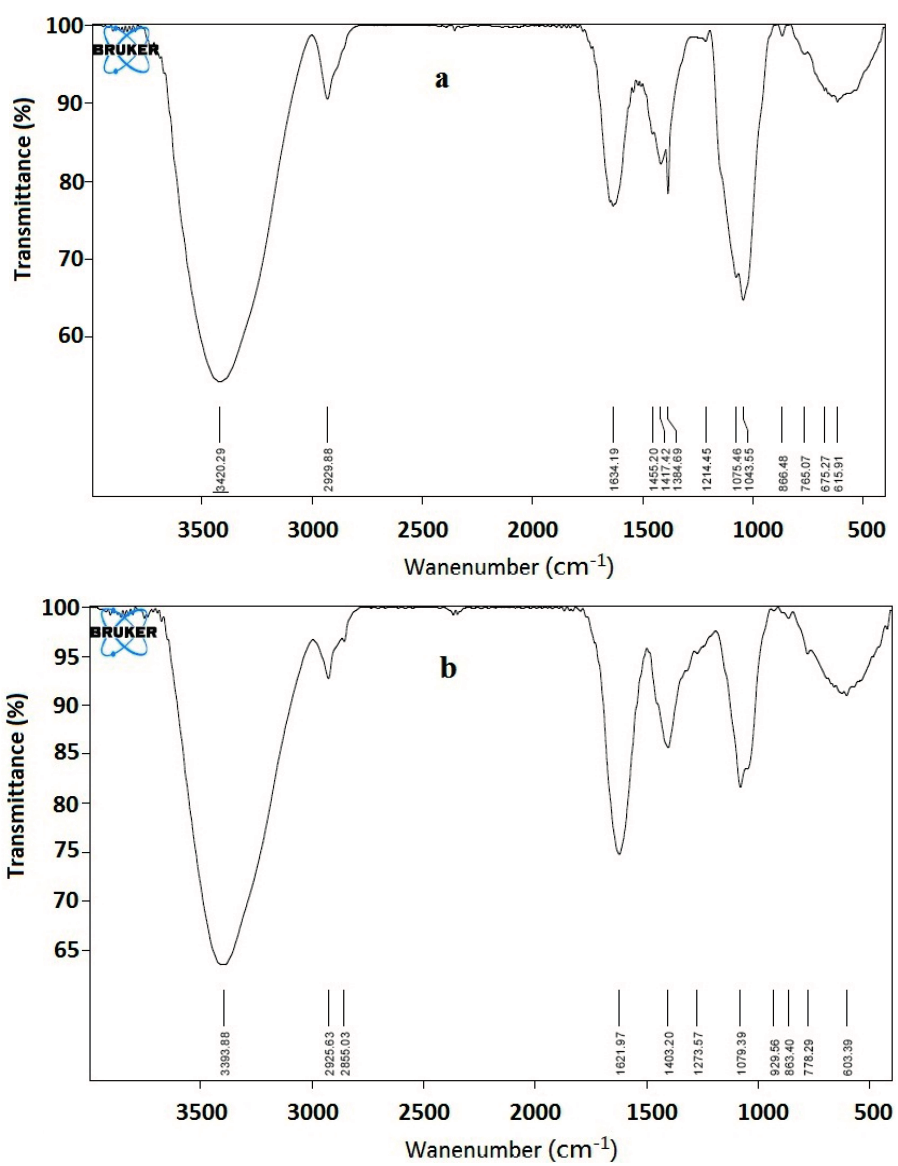
Figure 4. IR spectrum of ( a ) PEA-1and ( b ) PEA-2.